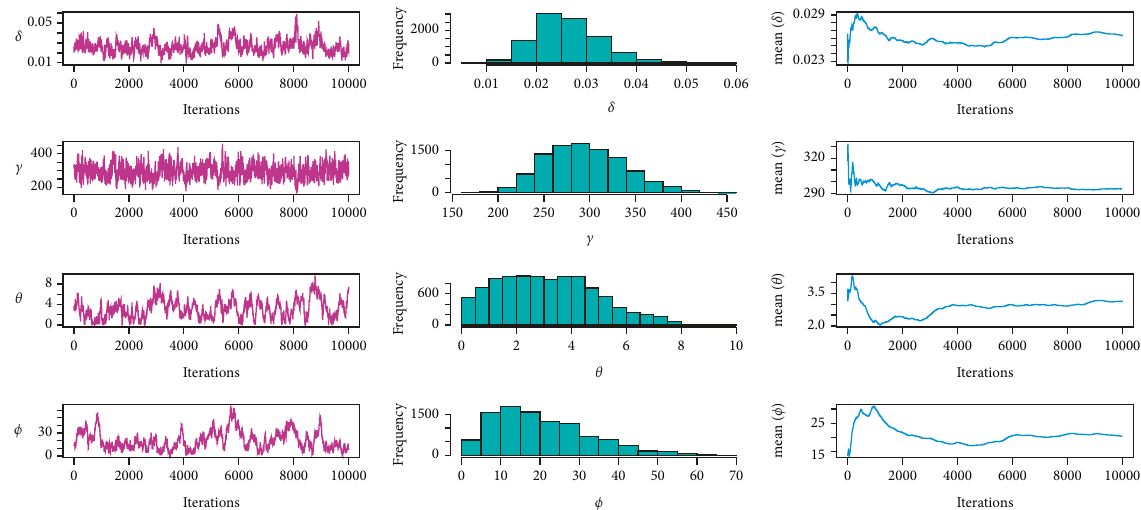
Figure 8: Convergence plots of MCMC for parameter estimates of IELoP distribution for dataset